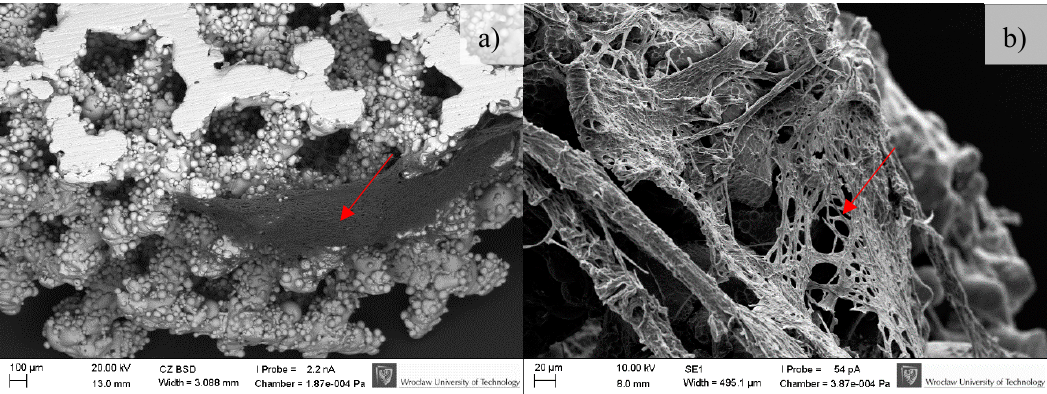
Figure 9. Osteoblasts after seven days of incubation on the tested implants. Samples not subjected (non-CP samples) ( a ) and subjected to chemical polishing (CP samples) ( b ). Blue arrow indicates BFS material; green arrow indicate adhered cells, while red ones extracellular matrix produced by osteoblasts, SEM.